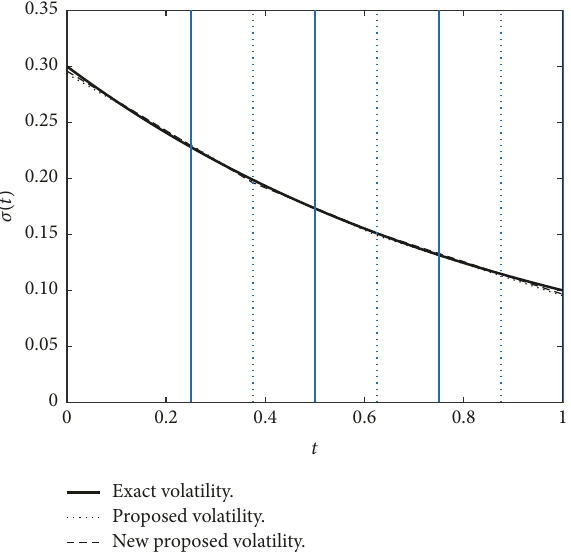
Figure 7: Construction of volatility by proposed algorithm and new proposed algorithm when the exact volatility is 𝜎(𝑡) = 0.3/3 𝑡 .